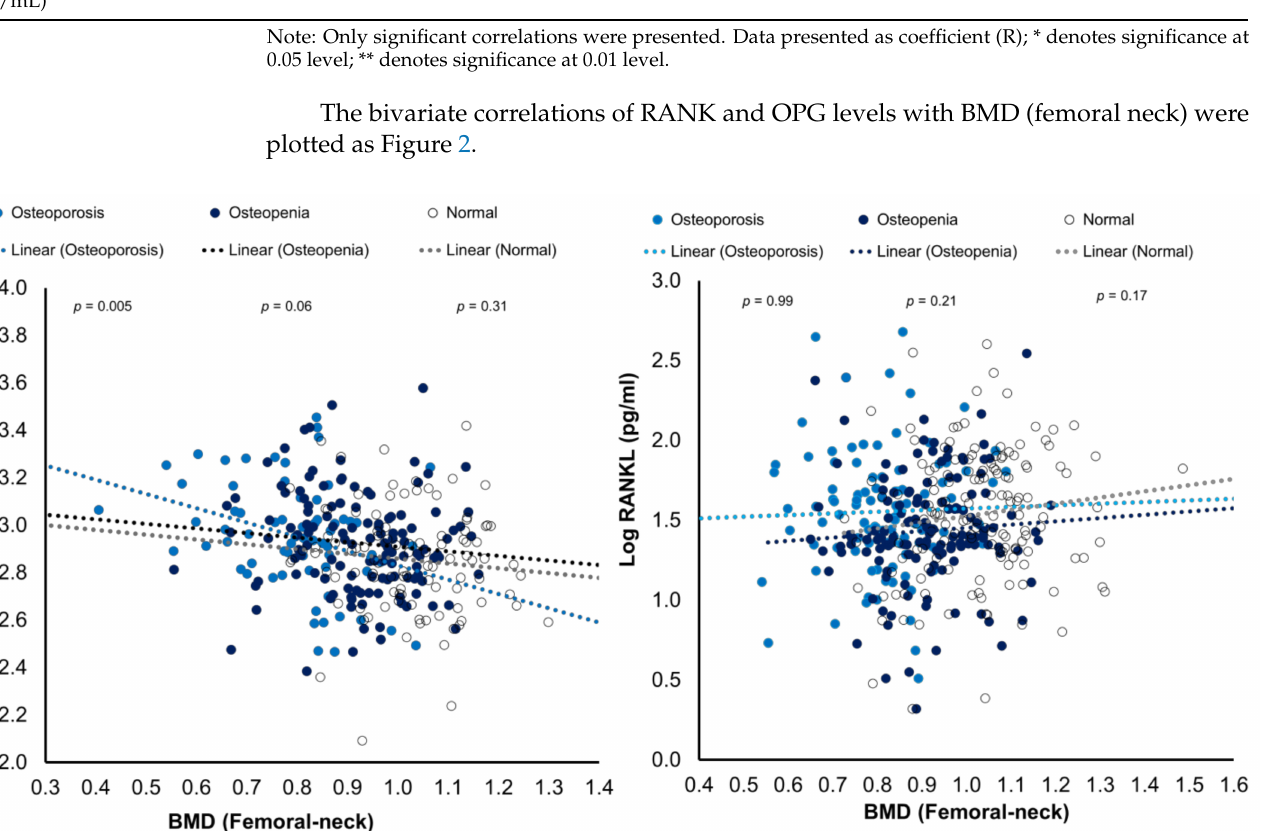
Figure 2. Scatterplots showing the associations of RANKL and OPG with BMD (femoral neck) in the three study